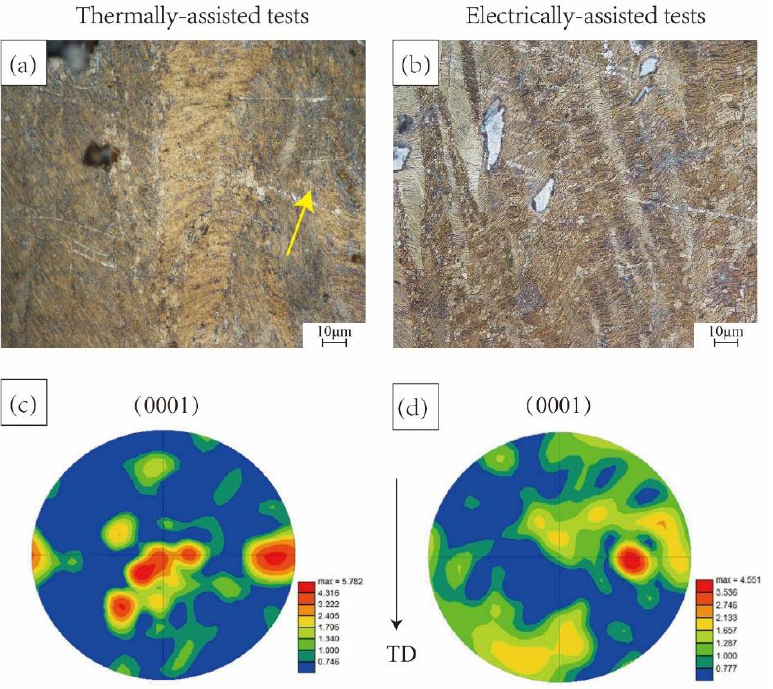
Figure 5. Microstructure and pole figures of the alloy ( a , c ) thermally assisted tests (200 °C) and ( b , d ) electrically assisted tests (26.58 A∙mm −2 ).